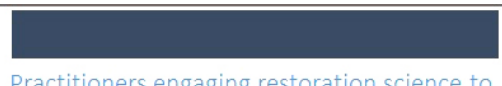
Fig. 4. The Iron Creek Properties project of The Stewardship Network.